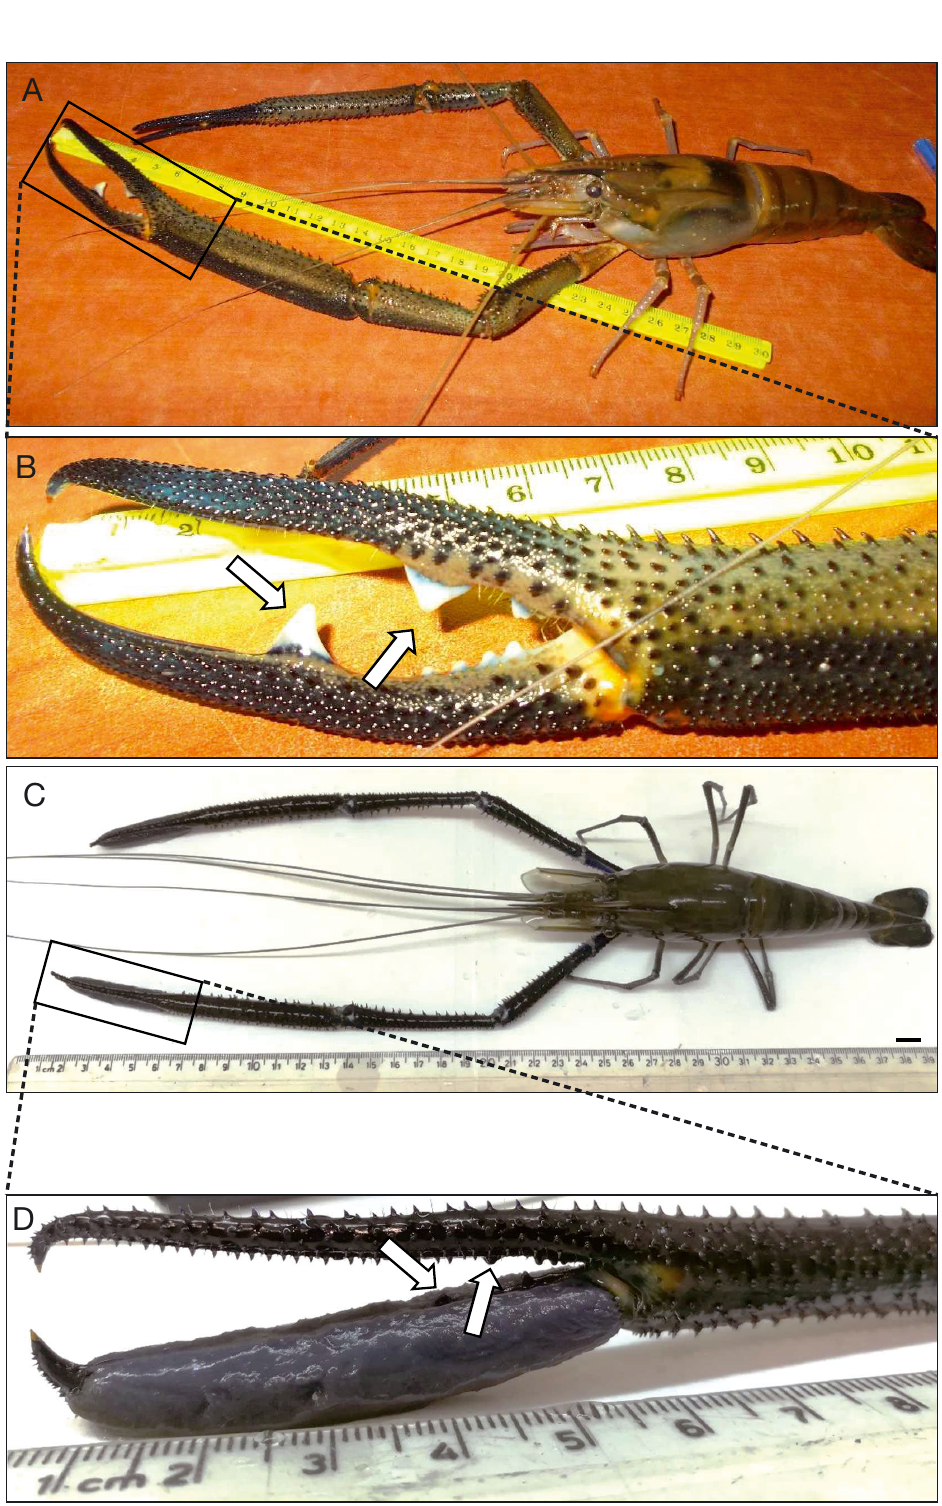
Fig. 2. Dorsal view of large males. (A) Overall view of a Macrobrachium vollenhovenii male. The yellow ruler is 30 cm long. (B) Enlargement of the tip of the propodus of a M. vollenhovenii male. White arrows indicate the locations of the 2 large propodus teeth. Ruler shows 1 cm intervals. (C) Overall view of a M. rosenbergii BC male. The ruler is 40 cm long. Bar represents 1 cm. (D) Enlargement of the tip of the propodus of a M. rosenbergii BC male. White arrows indicate the locations of the teeth inside the tip of the